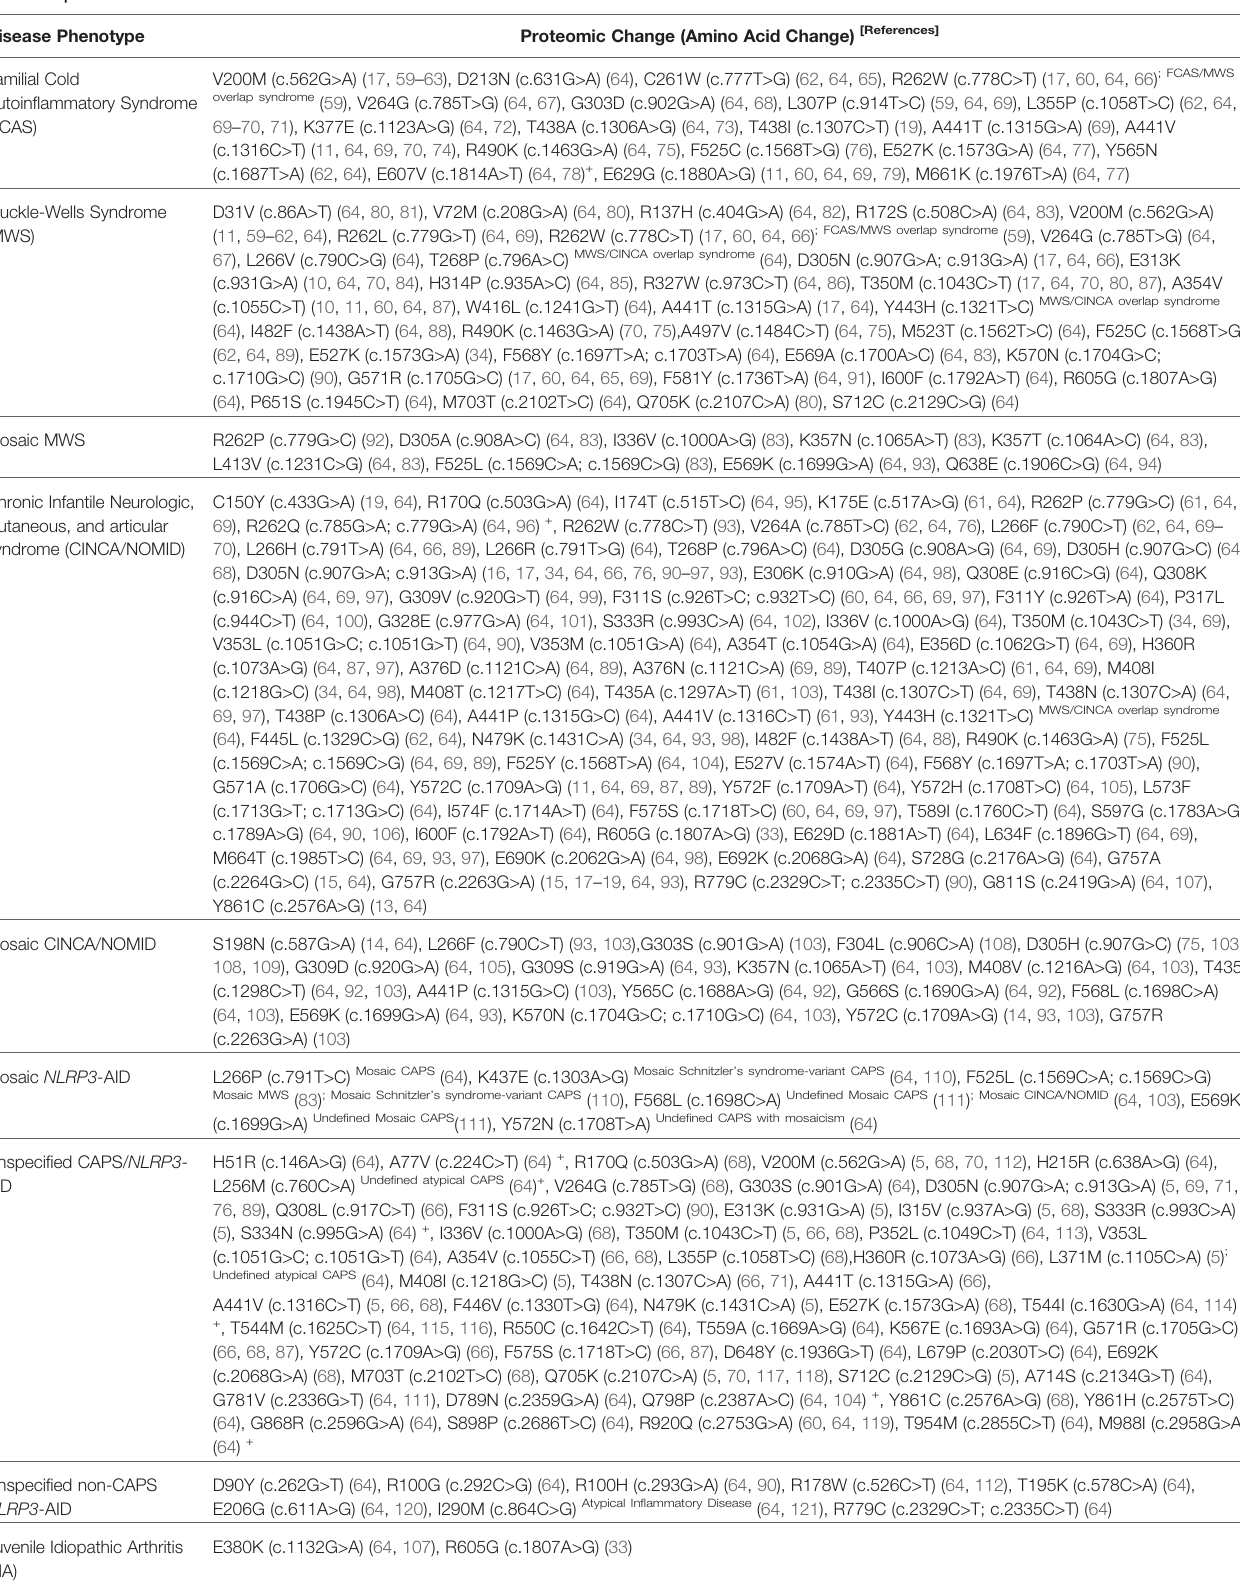
TABLE 1 | Literature Review of NLRP3 Germline